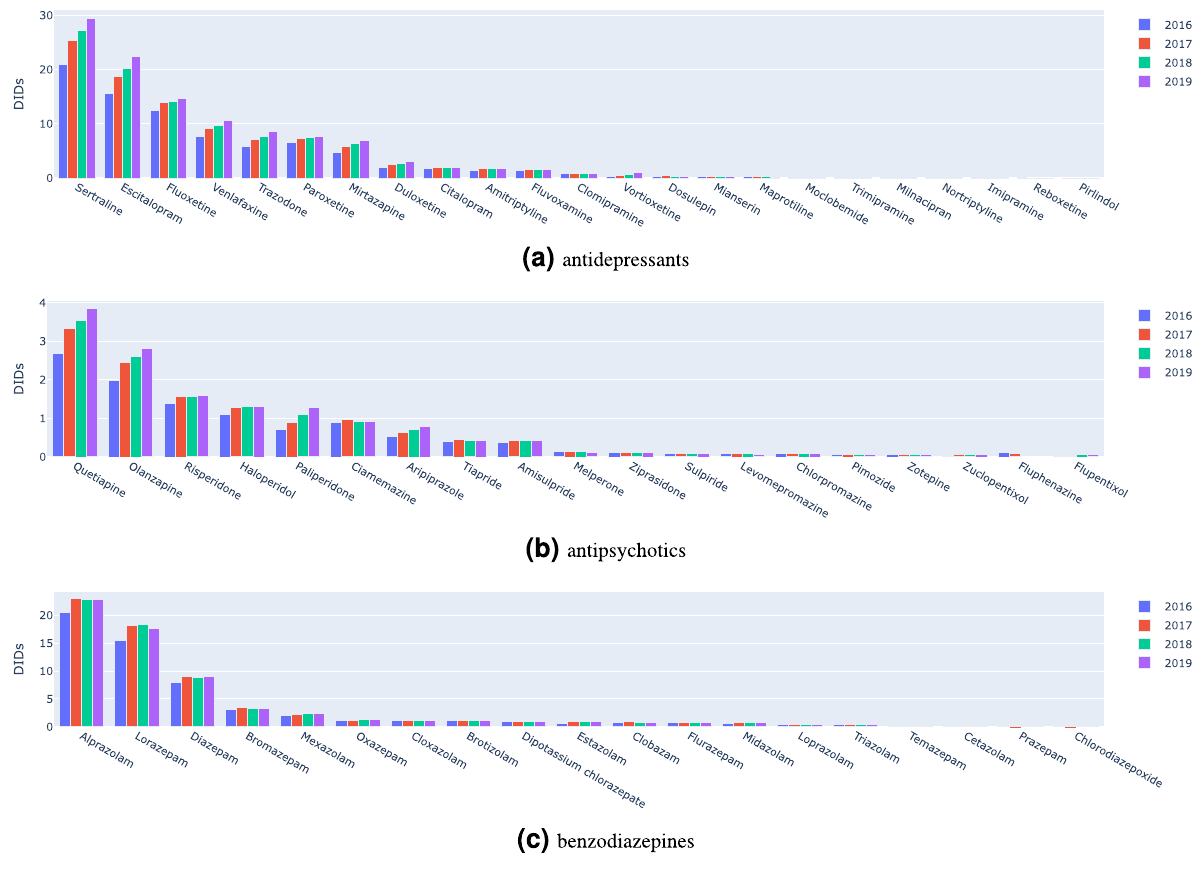
Figure 1. Defined daily dose per 1000 inhabitants-days (DIDs) per psychotropic drug